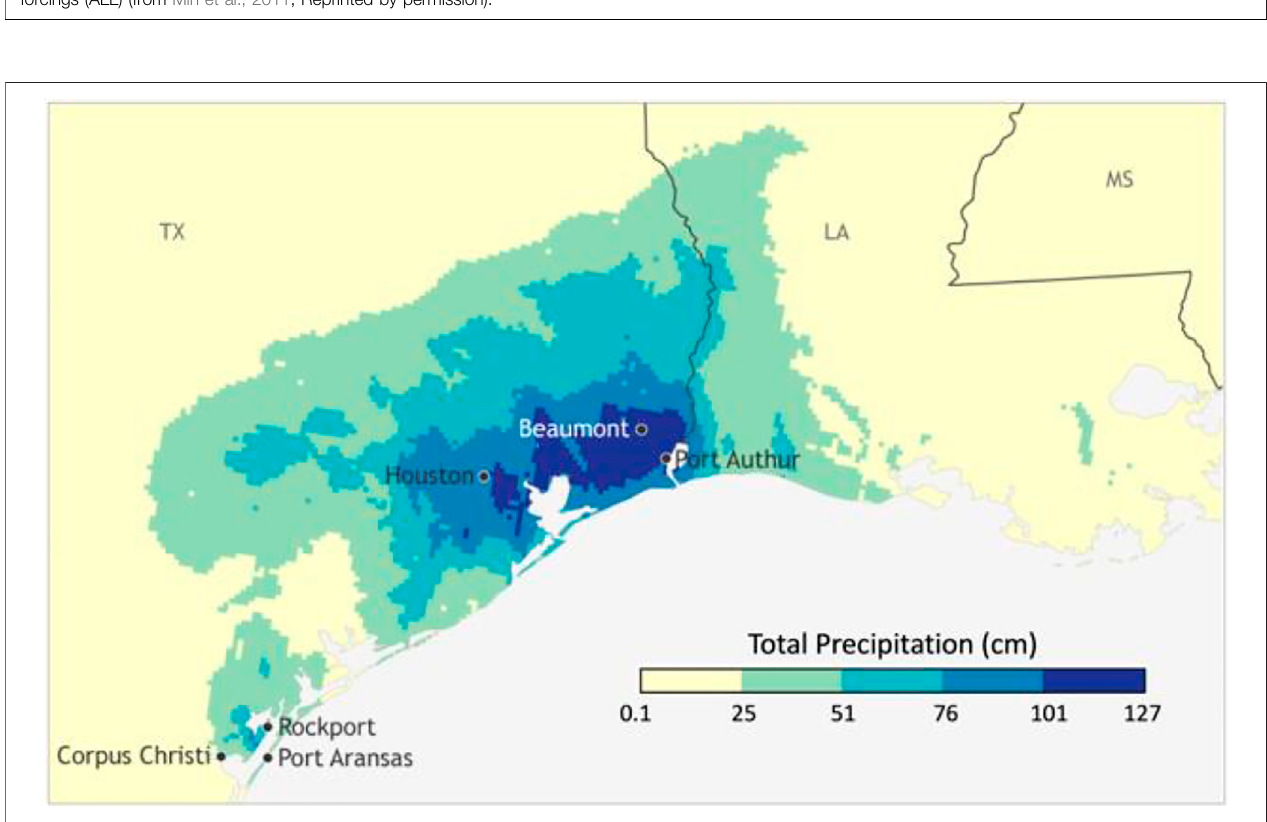
FIGURE 12 | Rainfall during Hurricane Harvey in the Houston vicinity. Peak rainfall was more than 1.5m over three days. (modi fi ed from https://www.climate.gov/ news-features/event-tracker/reviewing-hurricaneharveys-catastrophic-rain-and- fl ooding, accessed on 7 January 2021).